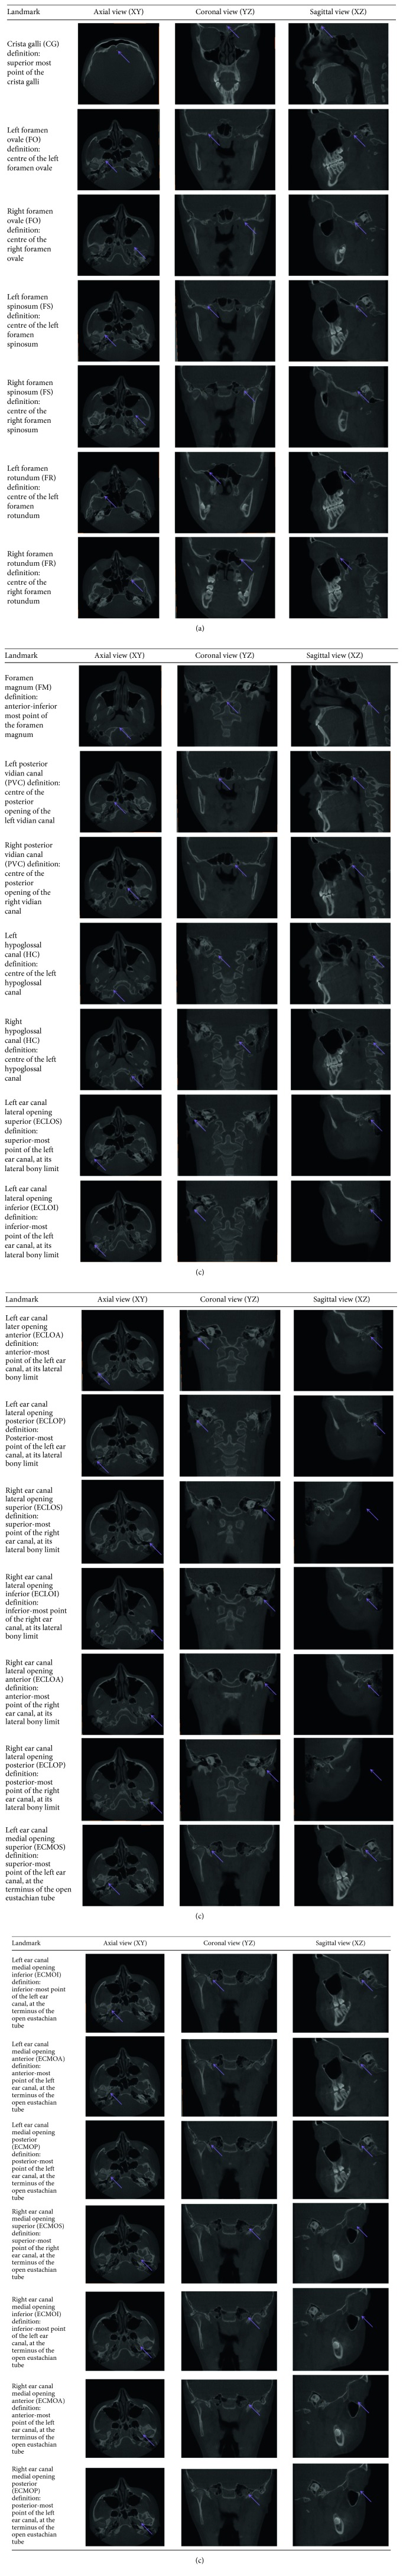
Landmarks used for reliability and distance analysis.